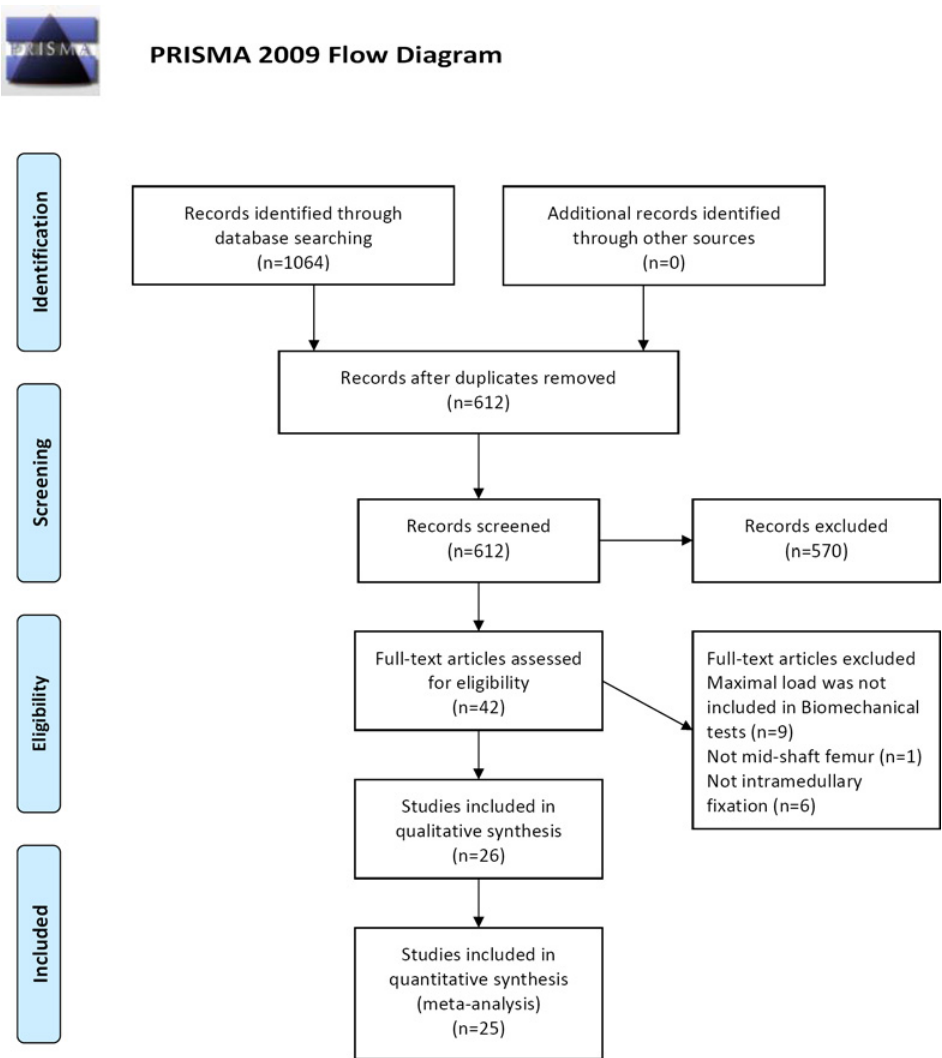
Fig 1. Study flow